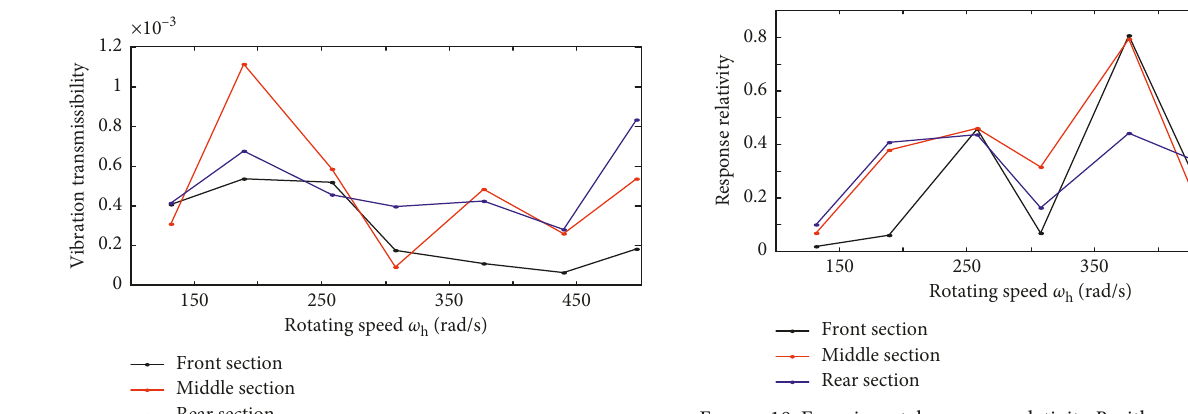
150rad/s, ω l 125rad/s, and (d) ω h (cid:30) (cid:30)